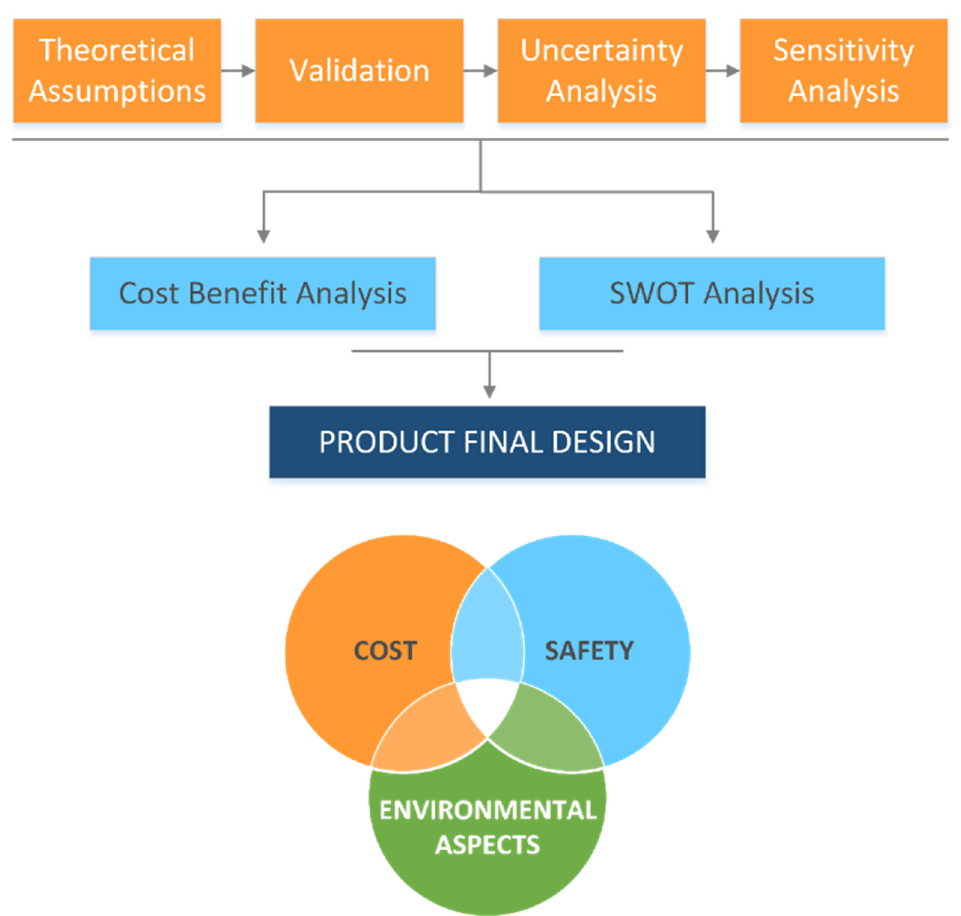
Figure 15. Modelling and Simulation Process for Products.